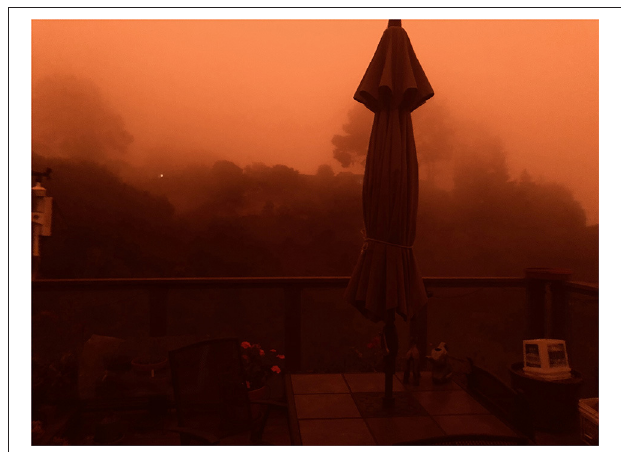
FIGURE 1 | View out the back in El Cerrito, California, September, 2020. Photo: L. Huntsinger.